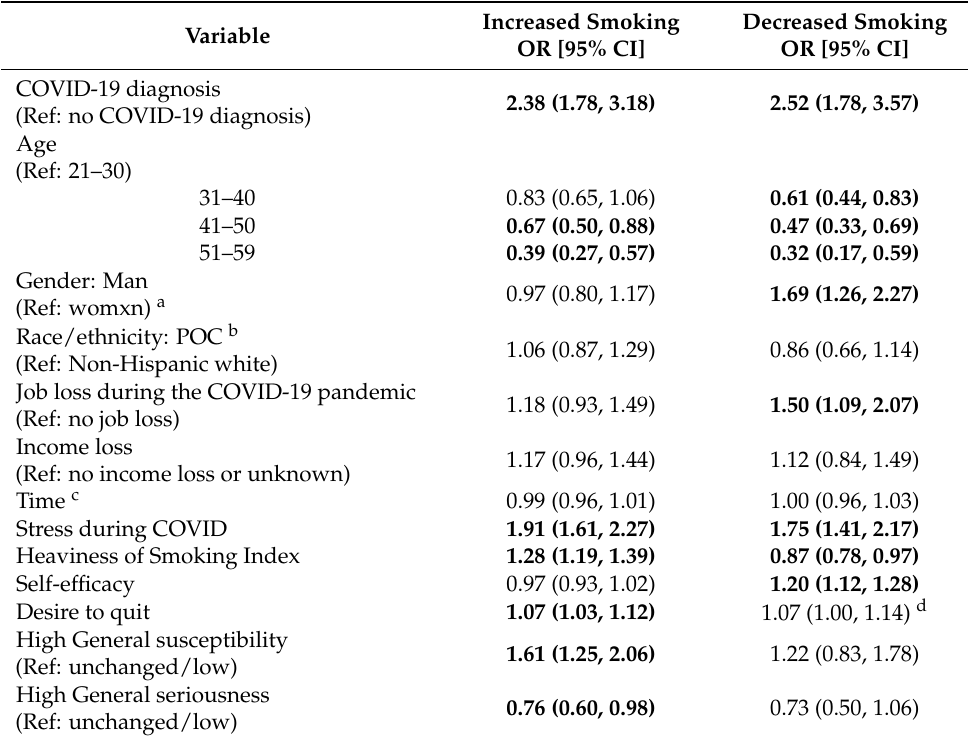
Table 3. Changes in smoking and general COVID-related perceptions among adults who smoke daily in 30 U.S. cities (N = 2768).